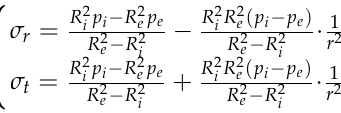
Figure 3. Illustration of the main stresses in a cylindrical body ( a ); radial and tangential stresses on an insulated volume element ( b ); calculation of the external radius: 𝑅 (cid:3032) (cid:4652)(cid:4652)(cid:4652)(cid:4652)⃗ = 𝑂𝐴(cid:4652)(cid:4652)(cid:4652)(cid:4652)(cid:4652)⃗ − 𝑂𝐵(cid:4652)(cid:4652)(cid:4652)(cid:4652)(cid:4652)⃗ ( c ); illustration of the mechanical equilibrium conditions ( d ).